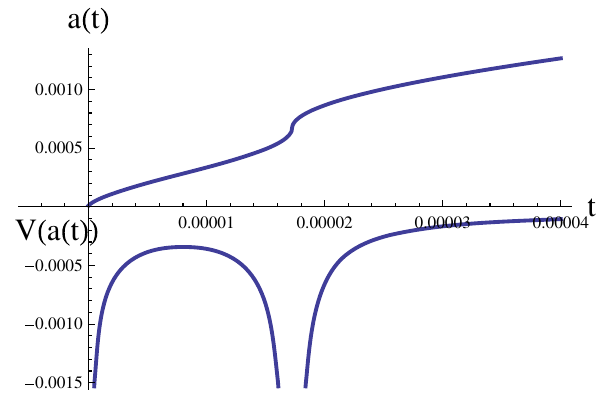
Fig. 9 Illustration of sewn freeze singularity, when the potential V ( a ) has a pole